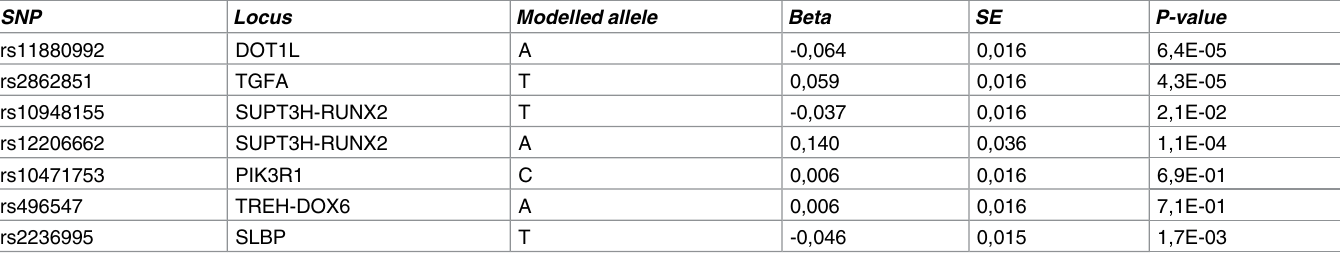
Table 2. Association of mJSW loci with Hip OA SNP